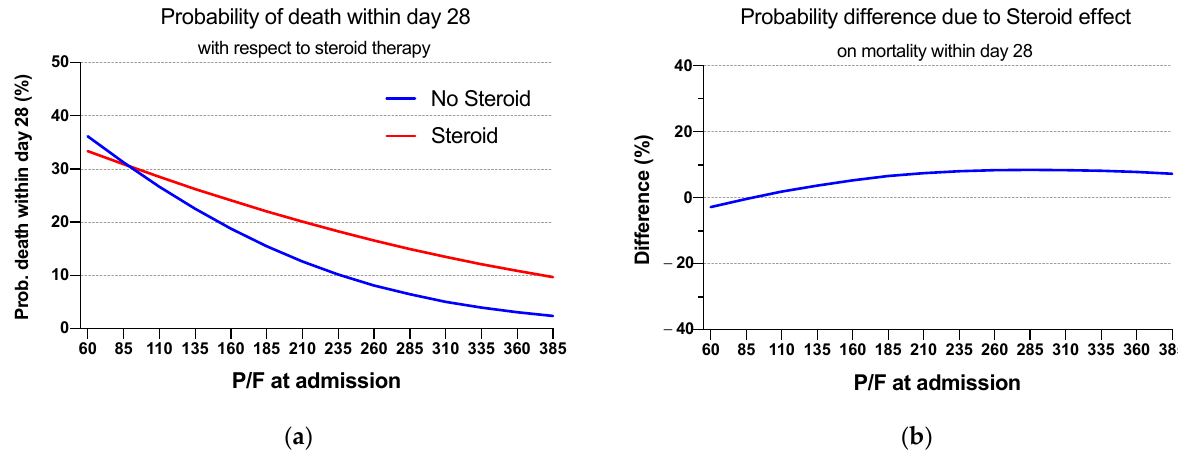
Figure 2. ( a ) Estimated probability of death within 28 days with respect to P/F values and steroid therapy. ( b ) Estimated difference in mortality within 28 days between exposed and unexposed cohort. Light blue shaded area shows confidence interval.